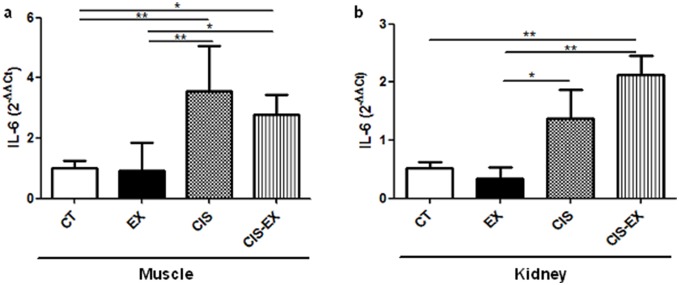
IL-6 contributes to kidney protection induced by exercise.The expression of the cytokine IL-6 was determined by qPCR in the muscle (A) and the kidney (B). The CIS group showed increased levels of IL-6 in both tissues compared to sedentary groups (CT and EX). However, CIS-EX showed increased IL-6 expression in the kidney, which indicates the protective role of IL-6 in this model. *P<0.05; **P<0.01.